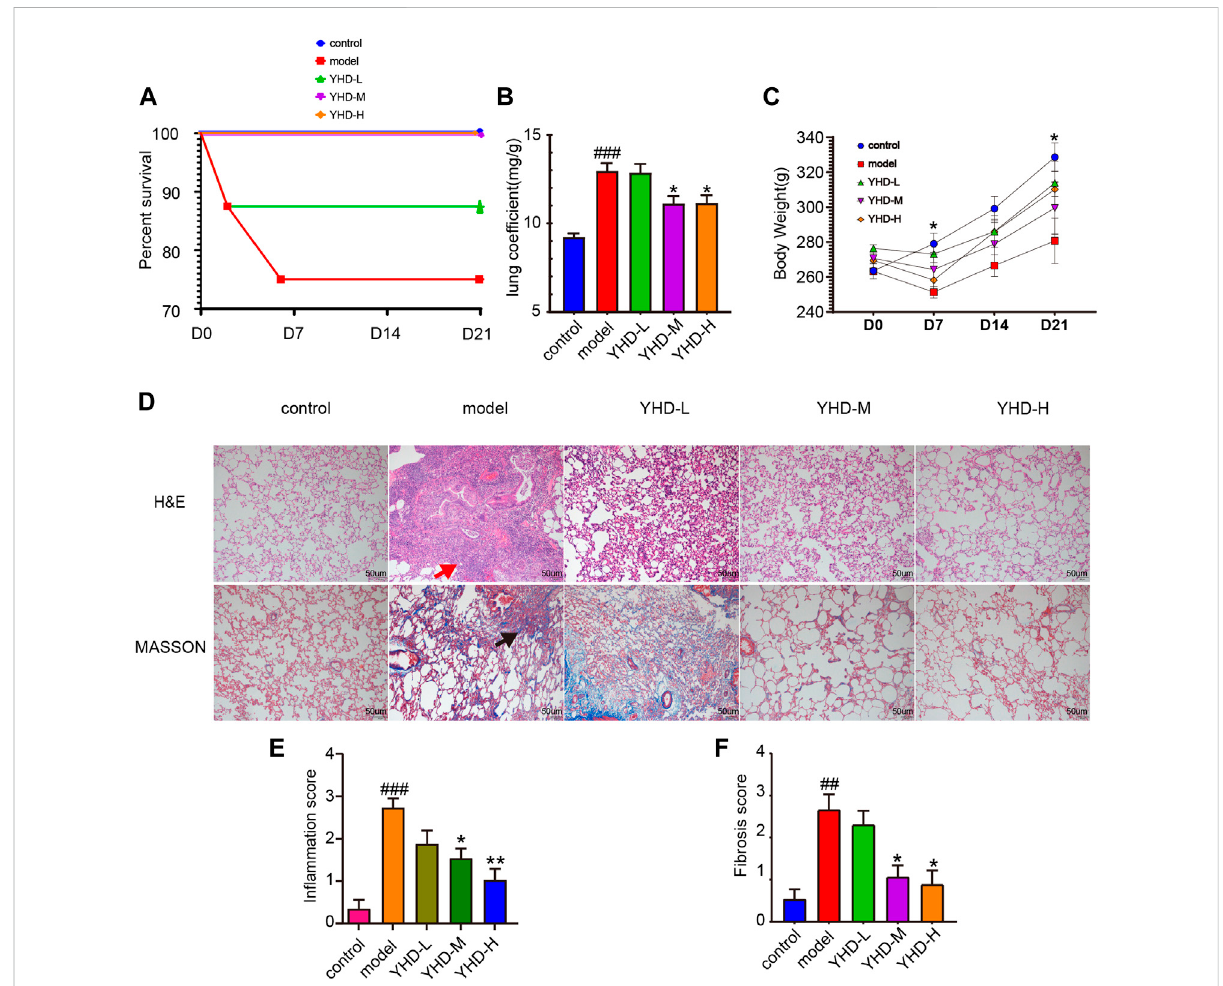
FIGURE 3 YHDalleviatedBLM-inducedPFintherats. (A) Percentsurvival.Totaltworatsinthemodelgroupdied(onday2andday6,respectively),andone in the low-dose YHD group died (on day 2). No rats died in the remaining three groups. Each group of rats ended up with at least 6 biological replicates. (B) Lung coef fi cient. (C) Body weight. On day 7 and day 21, there was a statistical difference between the control and model group (n = 6). (D) Hematoxylin-Eosin and Masson staining (scale bar = 50 um). Thickening of the alveolar septum, destruction of alveolar structure, massive in fl ammatory cell in fi ltration in the alveolar space and interstitium (red arrows), and blue collagen fi bers (black arrows). (E – F) In fl ammation and fi brosis score. In fl ammation and fi brosis scores were assessed based on HE-stained and MASSON-stained sections, respectively. Data were presentedasthemeans±SEM.### p < 0.001,comparedwiththecontrolgroup;* p < 0.05,** p <